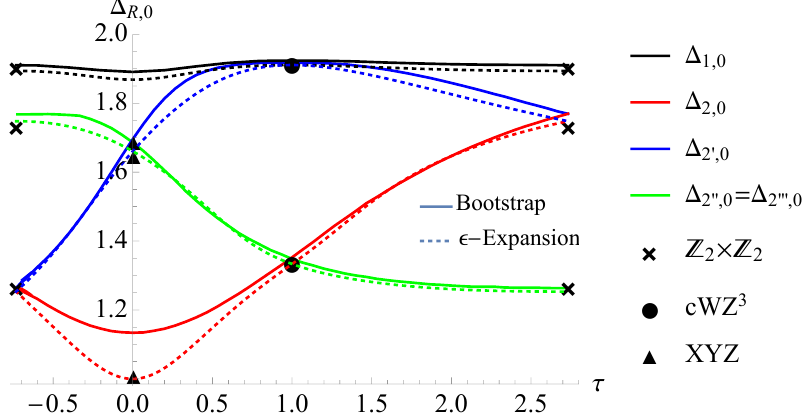
Figure 5 . Upper bounds on the unprotected scaling dimensions of the scalar singlet and doublets p p for real 1 (cid:0) 3 (cid:20) (cid:28) (cid:20) 1 + 3, computed using the G o Z 2 (cid:13)avor symmetry crossing equations.